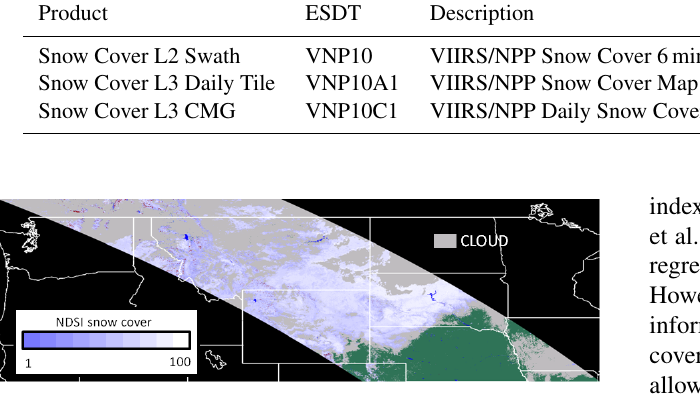
Figure 7. Snow-cover MOD10A1.A2016366.h10v04.006. ∗ .hdf. Snow cover across the Plains and Rockies on 31 December 2016. The tile has been projected to geographic grid.